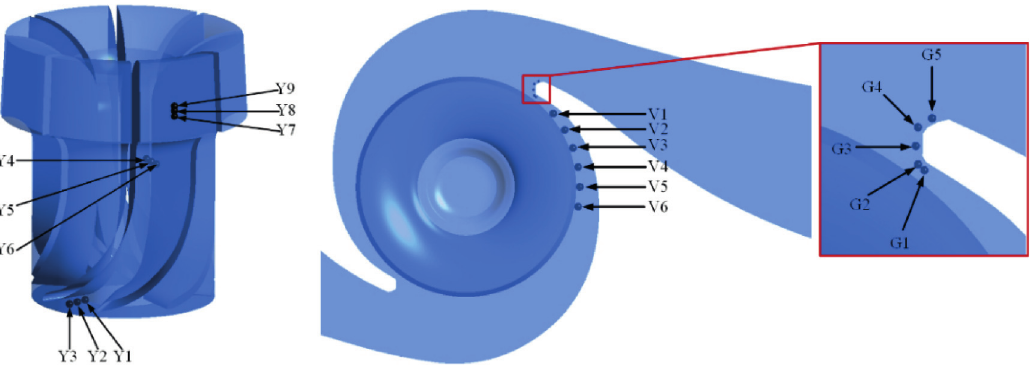
Figure 7: Monitoring points positions.